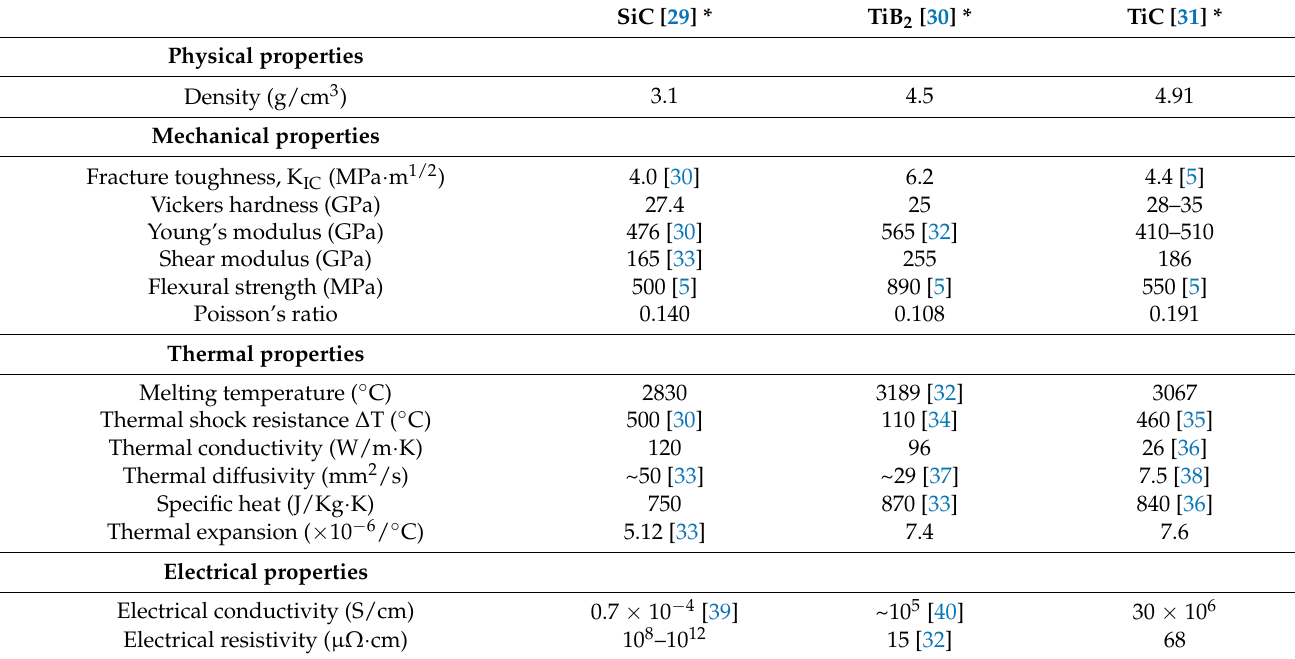
Table 1. Properties of SiC, TiC, and TiB 2 ceramic materials at room